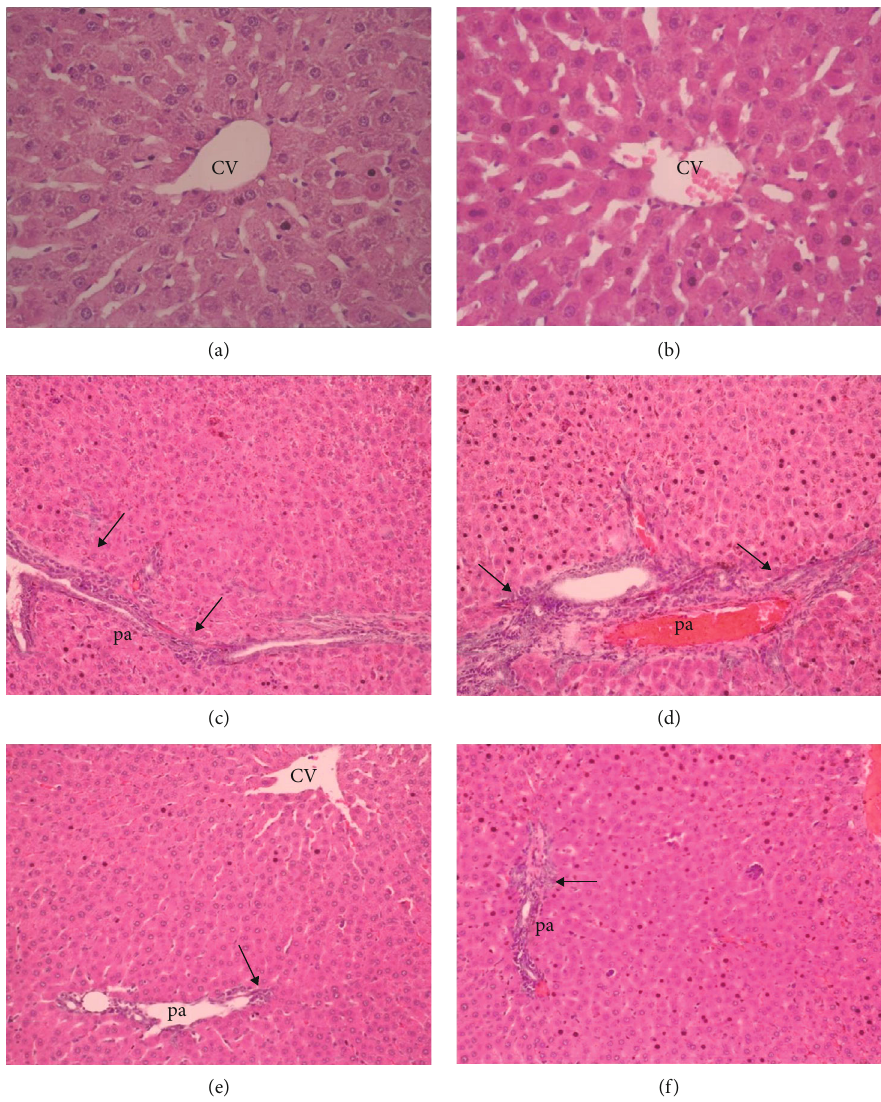
Figure 2: Liver histopathology H&E ( × 20 magni fi cation): (a, b) normal liver; (c, d) bridging necrosis, fi brosis, and cellular in fi ltration in the portal area (pa) (arrow), central venous (cv); (e, f) decreased bridging necrosis, fi brosis, and cellular in fi ltration in the portal area (pa) (arrow). Table 2: Biochemical analysis of the results. Normal MTX+saline